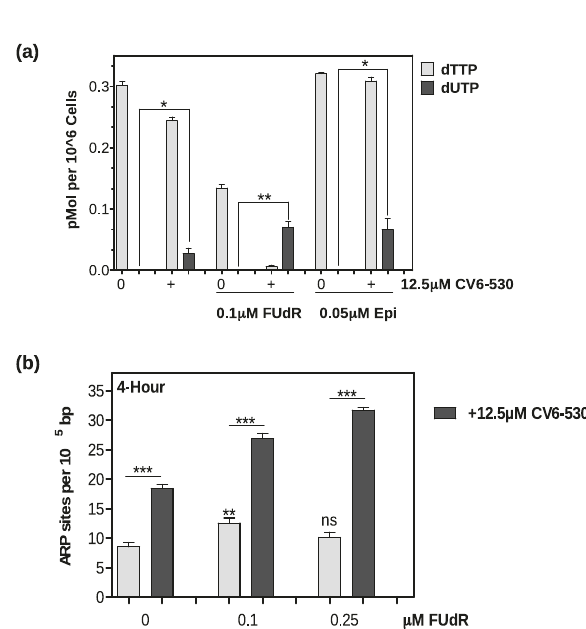
Fig. 6 Inhibition of dUTPase enhances uracil pool expansion and uracil misincorporation in TNBC cells treated with FUdR or epirubicin. a MDA-MB-468 cells were treated for 24 h with 0.1 µM FUdR or 0.05 µM epirubicin (Epi) alone or in combination with 12.5 µM CV6-530 before cells were collected for nucleotide pool analysis using a previously described 31 96-well fl uorescence-based assay to measure dTTP and dUTP levels. b MDA-MB-468 cells were treated with 0.1 or 0.25 µM FUdR alone or in combination with 12.5 µM CV6-530 before genomic DNA was collected using Pure- Link ® Genomic DNA Mini Kit (Invitrogen) for ARP site analysis using a luminescence-based assay (Promega). All data points are expressed as mean ± SEM ( N = 3 independent experiments). ns, not signi fi cant; * P < 0.05; ** P < 0.01; *** P < 0.001 by an unpaired, two-tailed Student t